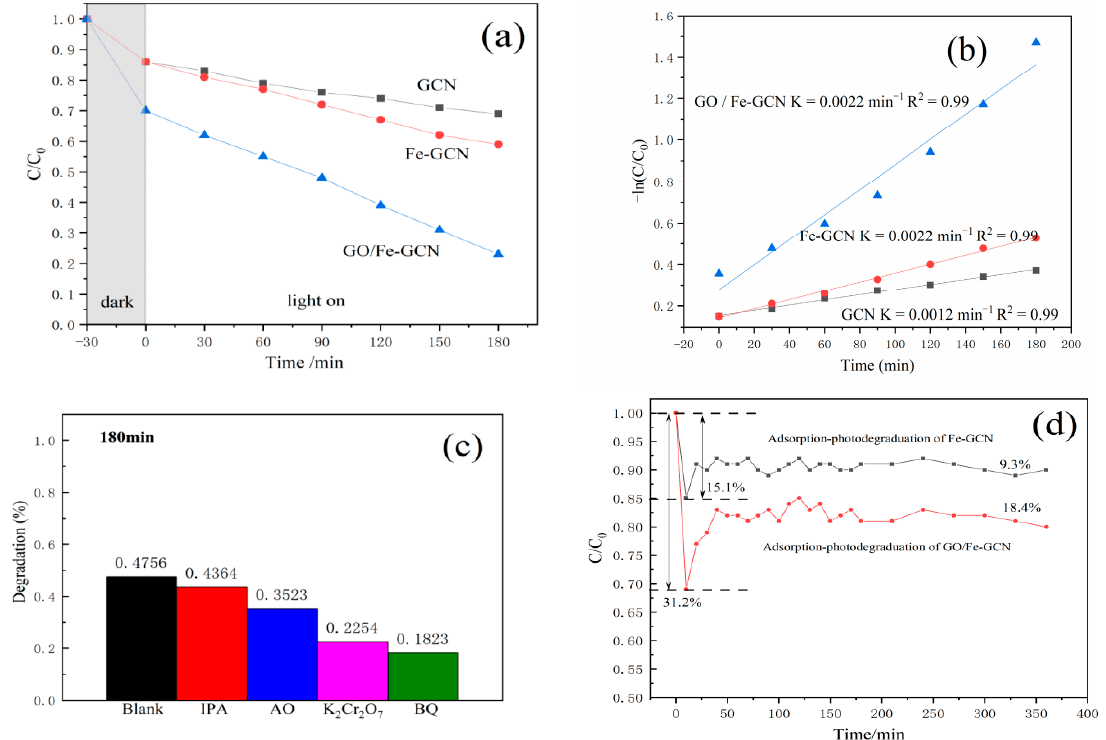
Figure 6. The visible light photocatalytic degradation rate of GCN, Fe-GCN, and GO/Fe-GCN for Rh B ( a ). The quasi-first-order reaction kinetic rate of GCN, Fe-GCN, and GO/Fe-GCN towards Rh B ( b ). Addition of active substance catcher in the quenching experiment for GO/Fe-GCN ( c ). The synergy of adsorption–photocatalytic degradation performance of Fe-GCN and GO/Fe-GCN in the dynamic system ( d ).